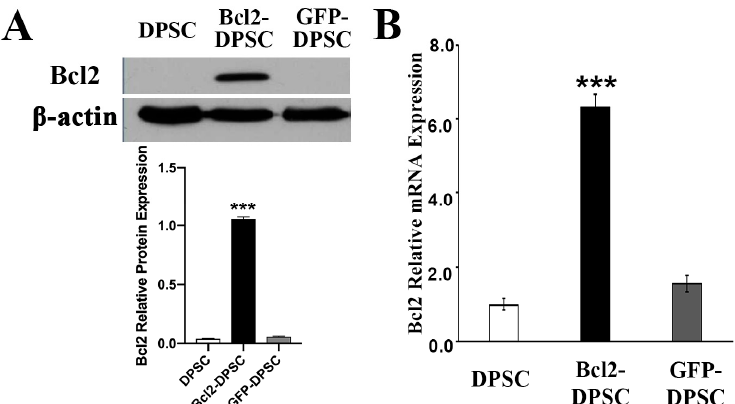
Figure 1. B-cell lymphoma 2 ( Bcl-2 ) overexpression in dental pulp stem cells (DPSCs). ( A ) Western blot analysis and ( B ) real-time polymerase chain reaction of Bcl-2 protein and mRNA expression in Bcl-2- and green fluorescent protein (GFP)-transfected, and parental DPSCs. β -actin – endogenous control *** p < 0.001 versus the corresponding controls.